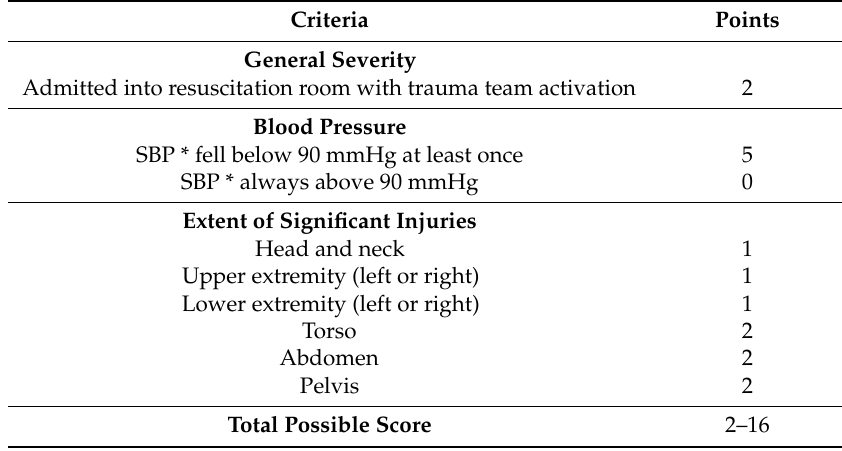
Table 1. modified Trauma Induced Coagulopathy Clinical Score (Mticcs)